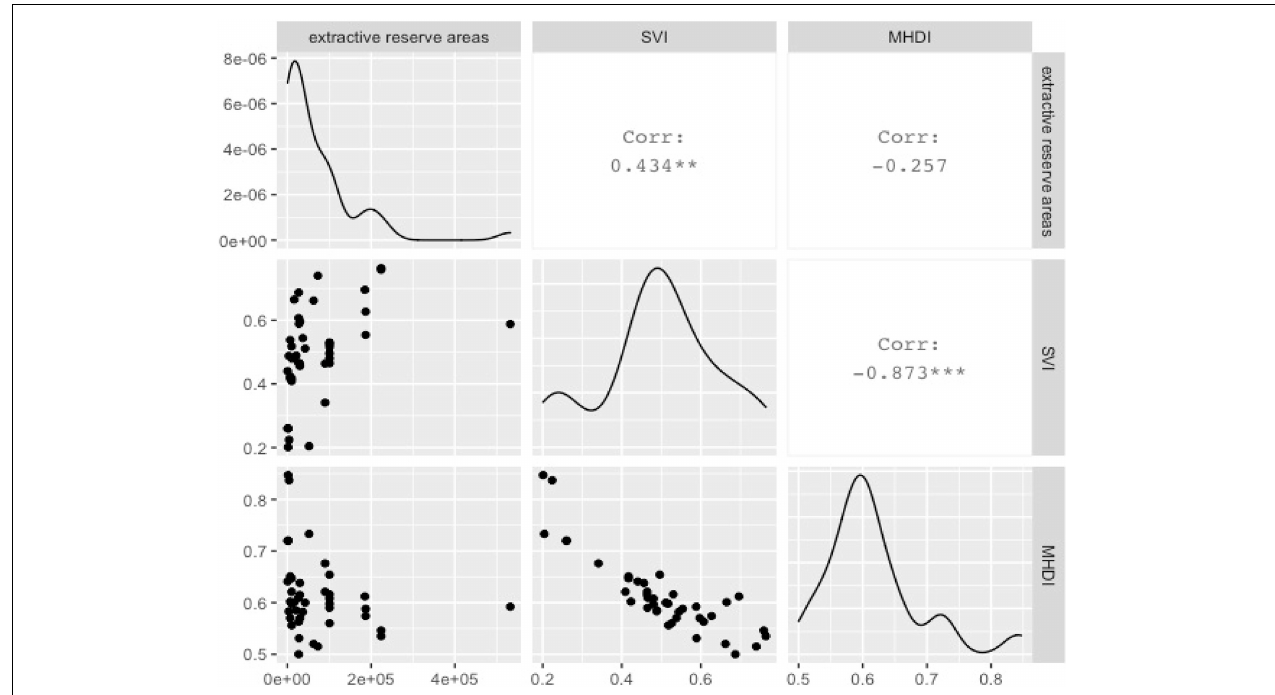
FIGURE 17 | Correlation between municipal extractive reserves areas, SVI, and MHDI. Elaborated by the authors with data from the Painel Unidade de Conservação Brasileiras—Ministério do Meio Ambiente, Atlas of Human Development in Brazil (IPEA, PNUD, and FJP), and Atlas of Social Vulnerability in Brazil